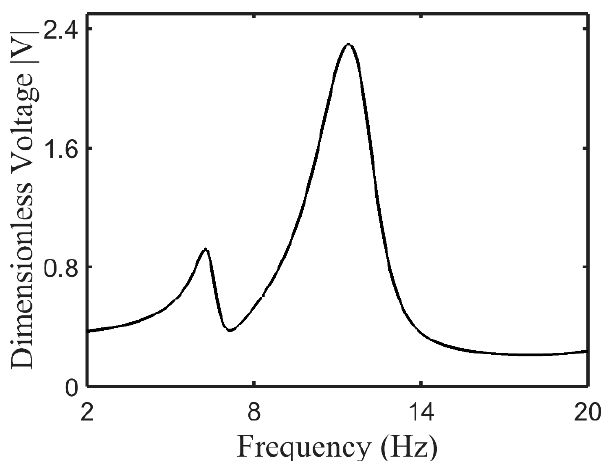
Figure 3. Dimensionless voltage versus frequency curve.